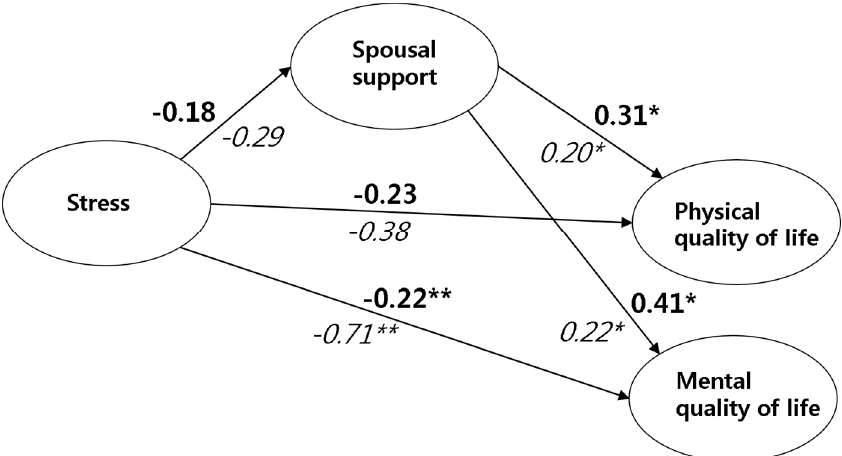
Figure 3. Moderating effects of breastfeeding experience on spousal support in the relationship between stress and health-related quality of life ( β ); * p < 0.050; ** p < 0.010; Bold : standardized estimated β coefficient of the breastfeeding experience (+) group; Italic : standardized estimated β coefficient of the breastfeeding experience (-) group.